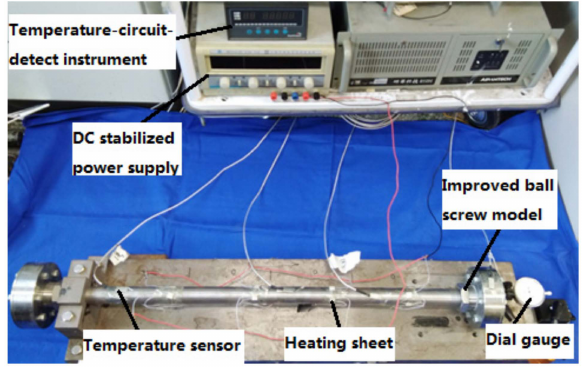
Figure 18. Experimental